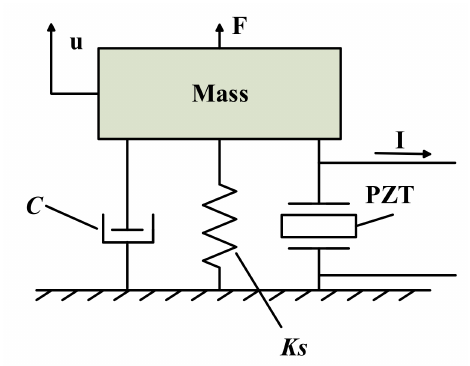
Figure 1. Electromechanical coupling